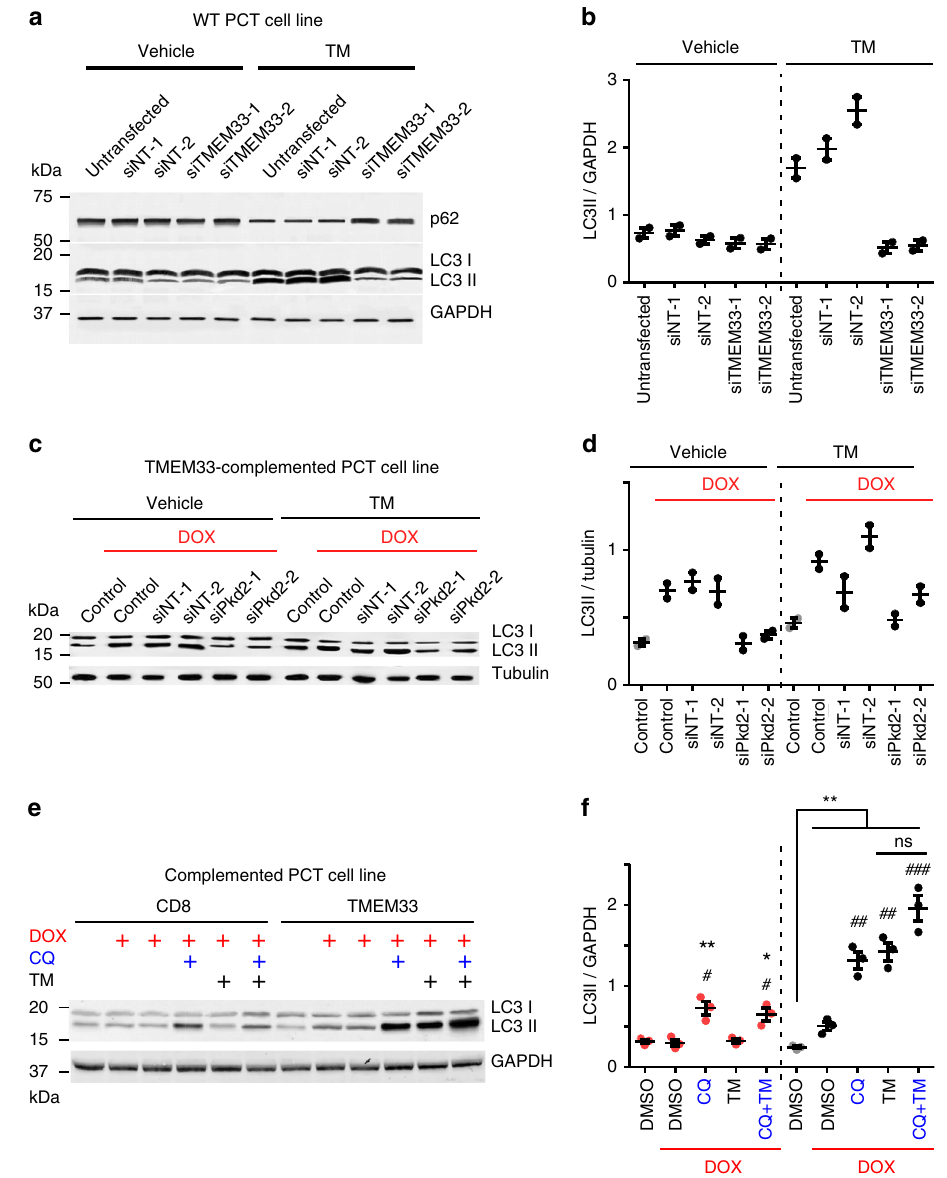
Fig. 5 TMEM33/PC2 and the regulation of autophagy. a p62, LC3II/LC3I and GAPDH expression in WT PCT cells transfected with control siNT or siTMEM33 siRNAs. Cells were either treated with the vehicle or with TM (1 μ g/ml for 16 h). Stimulation of autophagy induced by TM is seen as a decreased expression of p62 and increased LC3II/LC3I ratio. b LC3II/GAPDH ratio quanti fi ed from ( a ). c LC3II/LC3I and tubulin expression in TMEM33 − / − cells conditionally complemented with TMEM33 (upon DOX induction). Cells were transfected with control siNT or si Pkd2 siRNAs. Cells were either treated with the vehicle or with TM (1 μ g/ml for 12 h). d LC3II/tubulin ratio quanti fi ed from ( c ). Gray dots: uninduced cells; black dots: induced with DOX. e Estimation of autophagic fl ux in CD8- or TMEM33-complemented TMEM33 − / − stably complemented PCT cells. Treatments with doxycyline (DOX) to induce either CD8ER or TMEM33 expression is illustrated in red. Cells are treated either with vehicle (DMSO) or with TM (1 μ g/ml) for 8 h with or without chloroquine (20 μ g/ml)(CQ) for 2 h. f LC3II/GAPDH ratio quanti fi ed from e . Red dots: CD8; Gray dots: TMEM33 uninduced cells; black dots: TMEM33 induced with DOX. For TMEM33 expressing cells, the difference between DMSO and CQ is signi fi cant (**), while the difference between TM and TM + CQ is not signi fi cant. Values are means ± SEM overlaid with dot plots for b , d , f . One star indicates p < 0.05, two stars p < 0.01 and three stars p < 0.001, with a two-tailed Student ’ s t-test used to evaluate statistical signi fi cance. Source data are provided as a Source Data fi le estimated by counting the number of Cherry positive cells using TMEM33 was expressed in TMEM33 − / − , unlike in Pkd2 − / − cells a cell sorter and normalized to the control CD8ER condition [unless PC2 was complemented] (Fig. 6b). Of note, neither the (Fig. 6a). TMEM33 signi fi cantly lowered cell viability when number of annexin V positive cells nor caspase activity was transfected in a TMEM33 − / − background (Fig. 6a). Remarkably, signi fi cantly enhanced by TMEM33 expression in TMEM33 − / − cells (Fig. 6c, d). in Pkd2 − / − PCT cells this effect was absent, although the effect was recovered when PC2 was also complemented (Fig. 6a). Next, we used an in vitro model of PCT cells ER stress In addition, the number of DAPI positive cells (as an index induced by TM (1 μ g/ml; 16 h) 36,37 . In the conditional TMEM33 expressing PCT cell line, DOX addition induced a of membrane permeabilization) was signi fi cantly enhanced when NATURE COMMUNICATIONS| (2019) 10:2024